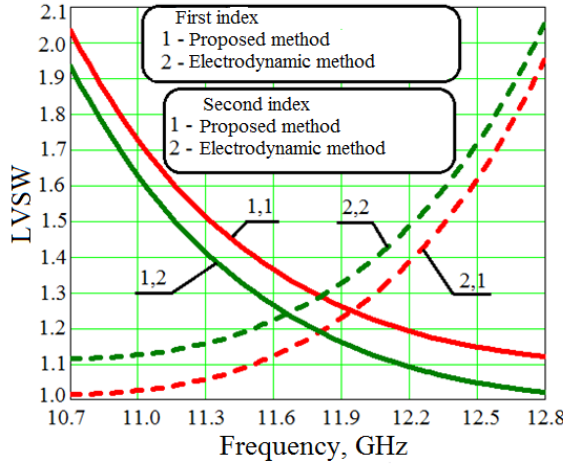
FIGURE 8. Ellipticity coefficient vs. frequency for the waveguide polarizer